Question: Describe this figure in one sentence.
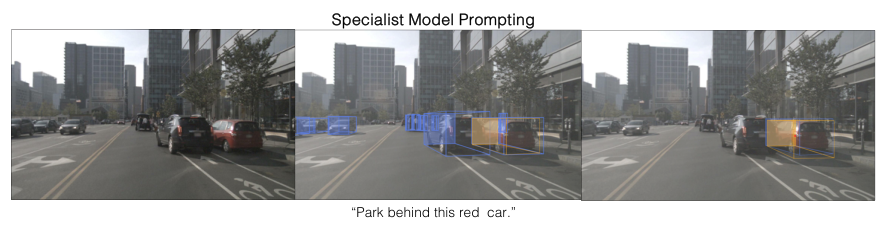
Answer: Cube-LLM inference with prompting. Top: Visual Chain-of-Thought Prompting to reason in 3D step-by-step. Bottom: Incorporating specialist models to further improve localization of Cube-LLM. Blue 3D boxes are the predictions of CenterPoint on corresponding LiDAR points.